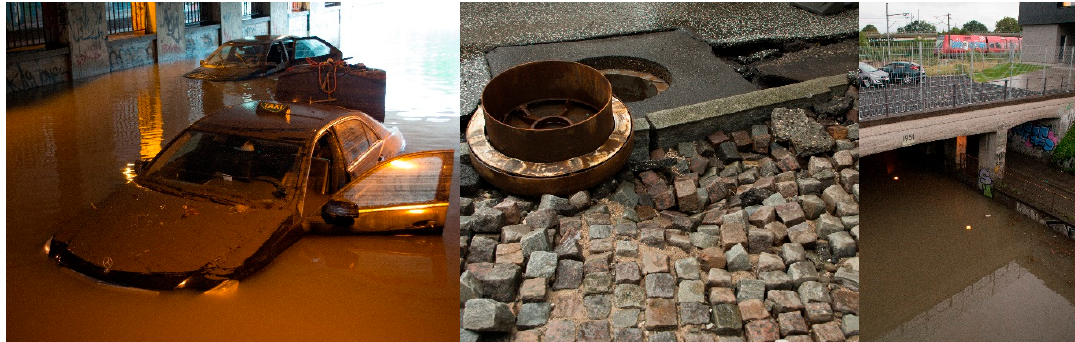
Figure 1. Pluvial flooding on the 31st of August 2014. Photos were taken at three different flood affected locations in Copenhagen (photo by Johanna Sörensen).